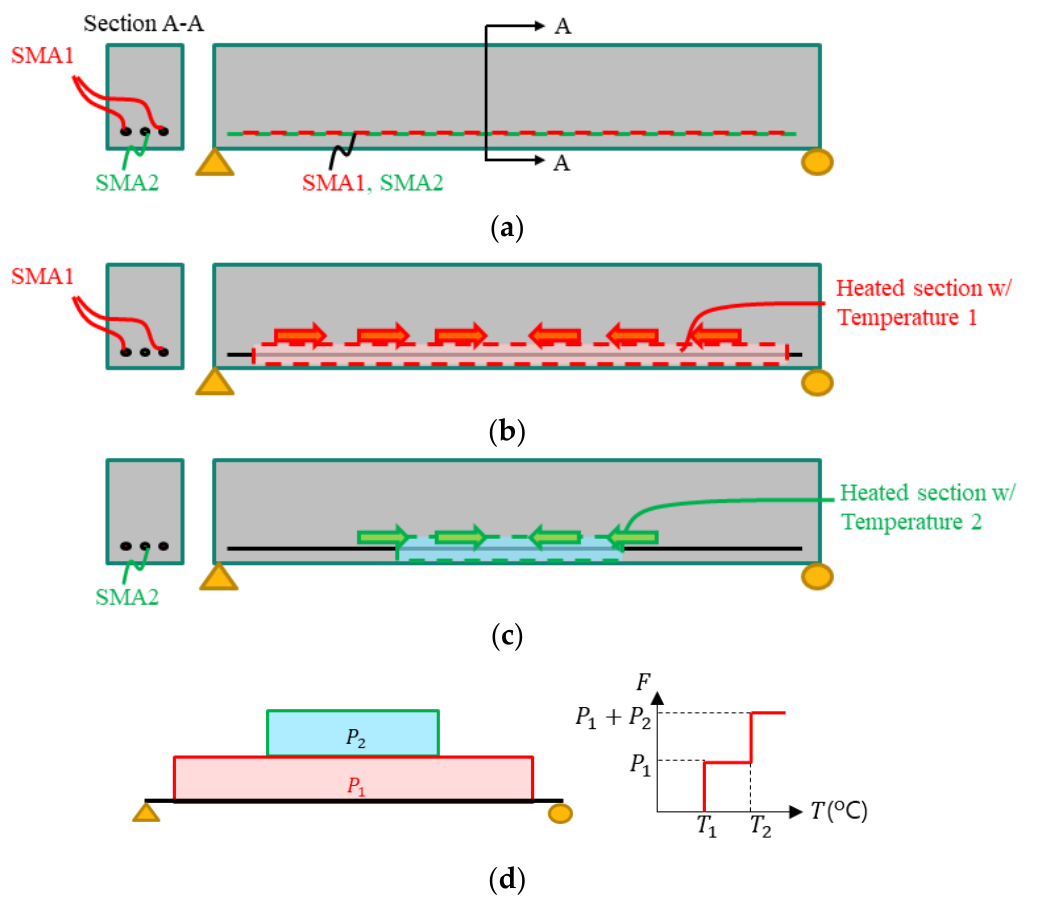
Figure 1. General application procedure of prestressing method using hybrid shape memory alloy (SMA) wires: ( a ) prestressed concrete girder with hybrid SMA wires; ( b ) heating of hybrid SMA wire to temperature 1; ( c ) heating of hybrid SMA wire to temperature 2; ( d ) final prestressing force distribution and multi-step prestressing force in section A.